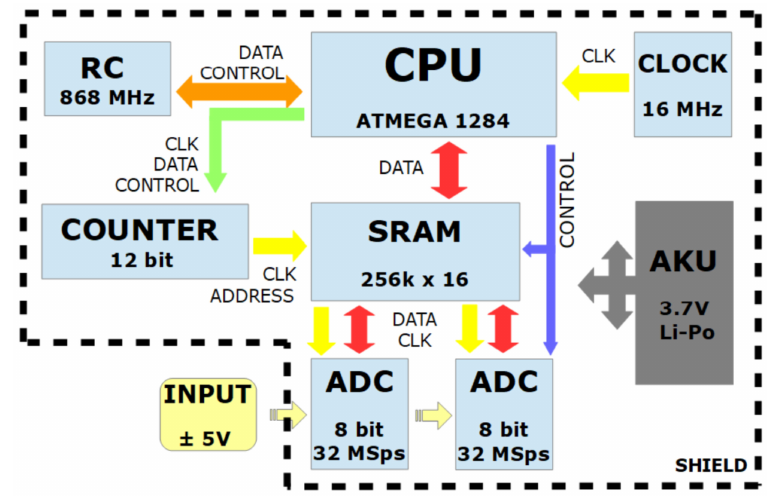
Figure 4. Block structure of the measuring device.